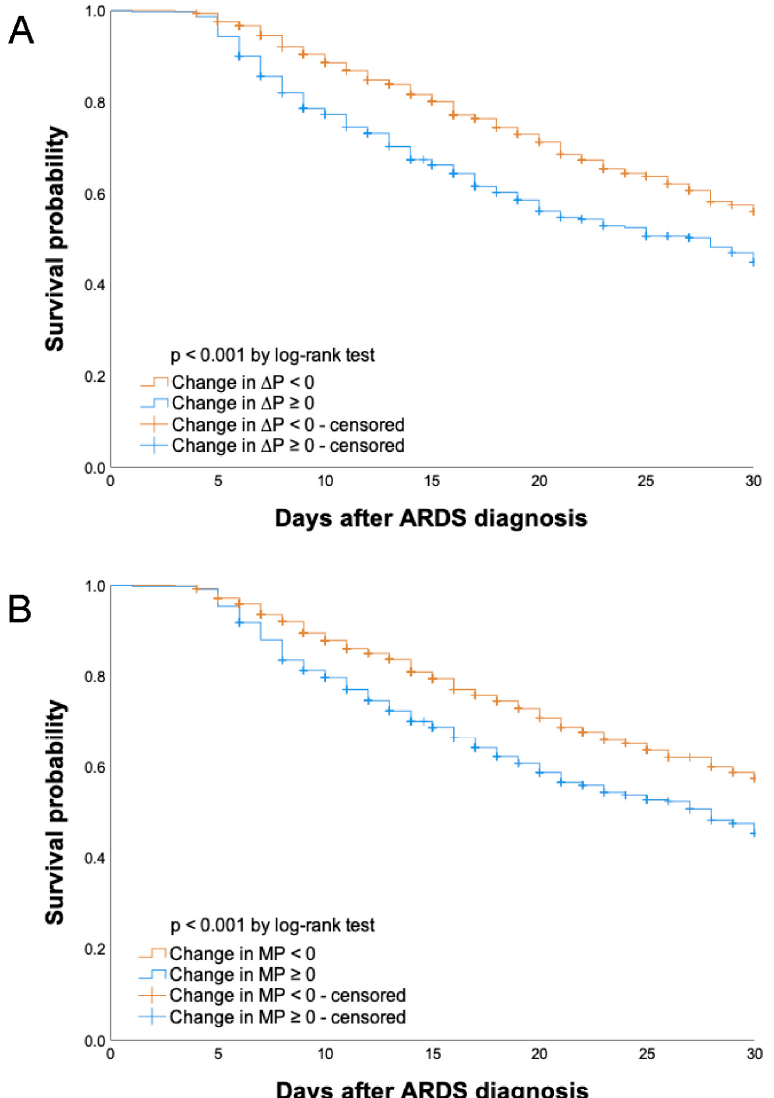
Figure 4. Kaplan–Meier graphs of 30-day cumulative survival in patients according to ( A ) changes in driving pressure ( ∆ P) and ( B ) changes in mechanical power (MP). Abbreviations: ARDS, acute respiratory distress